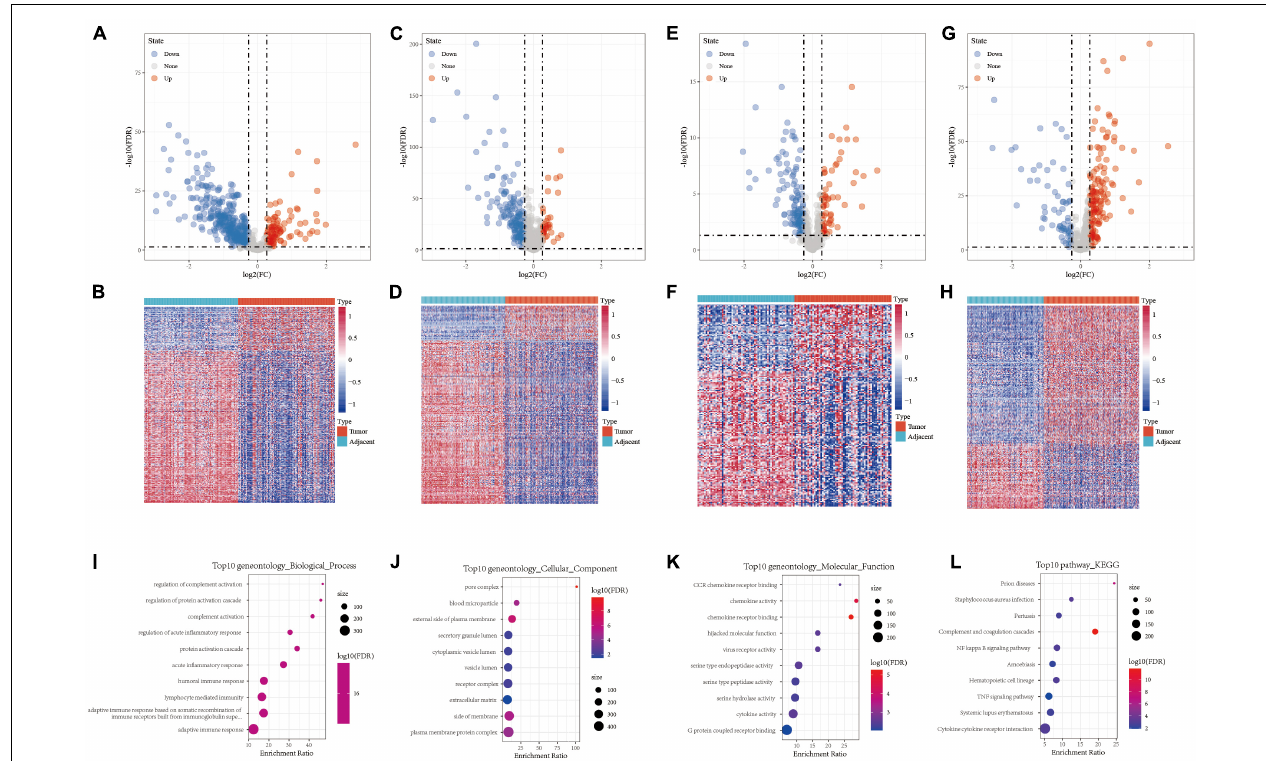
FIGURE 1 | (A,B) Volcano map and heat map of differentially expressed genes in GSE22058. (C,D) Volcano map and heat map of differentially expressed genes in GSE25097. (E,F) Volcano map and heat map of differentially expressed genes in GSE64041. (G,H) Volcano map and heat map of differentially expressed genes in GSE36376. (I) Bubble chart of differentially expressed genes in biological process. (J) Bubble chart of differentially expressed genes in cellular component. (K) Bubble chart of differentially expressed genes in molecular function. (L) Bubble chart of differentially expressed genes in KEGG pathway.